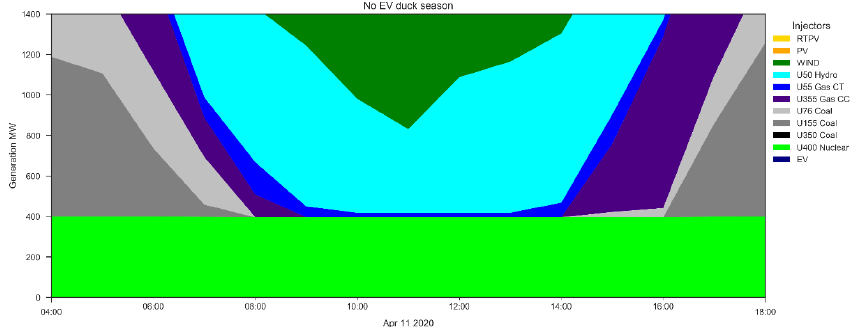
Figure 9. Zoomed-in view of the generation stack on April 11 (Duck curve) with no EVs.